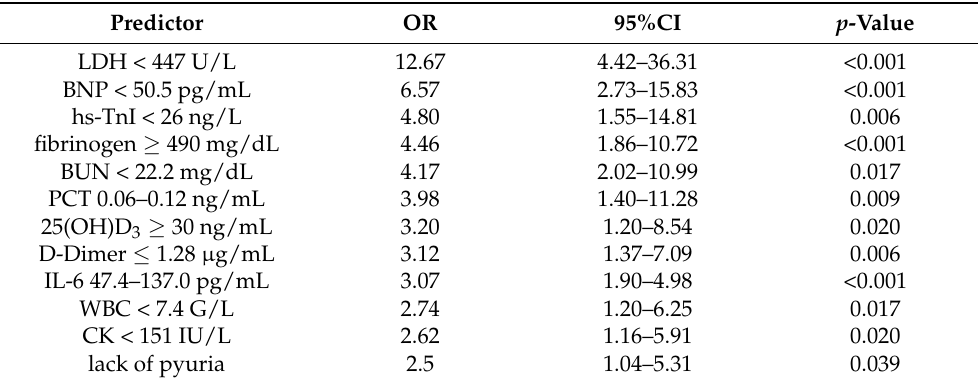
Table 3. Laboratory predictors of good response (measured in tocilizumab administration day). Analyses have been conducted on adjusted data.